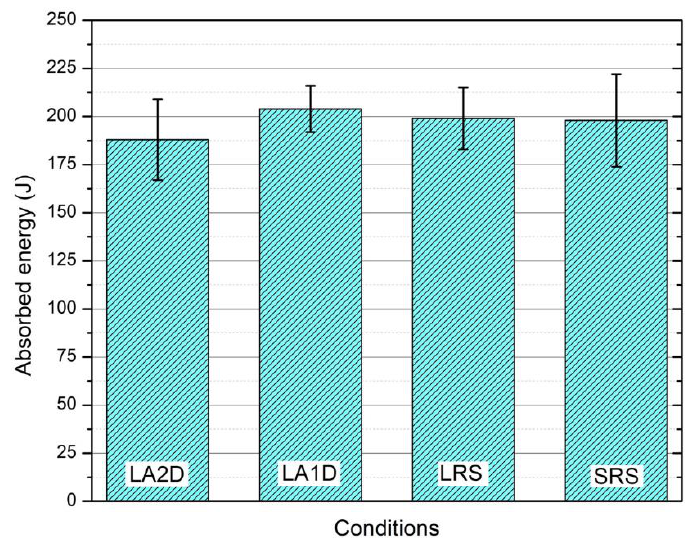
Figure 3. Energy absorption of studied configurations.